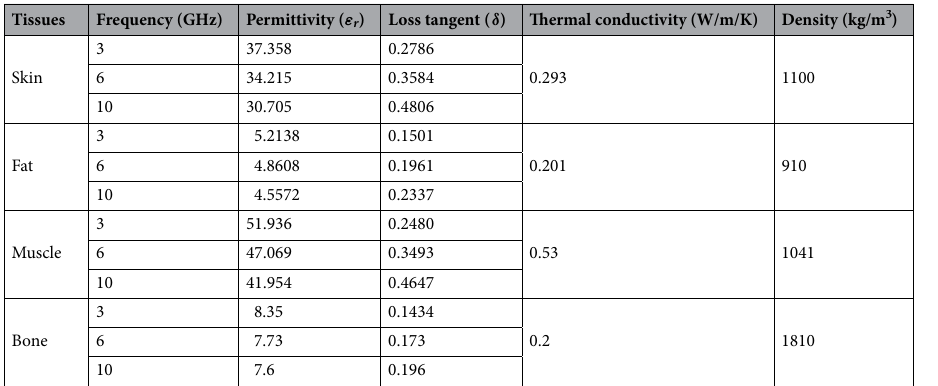
Table 1. Electrical properties of the human body tissues.